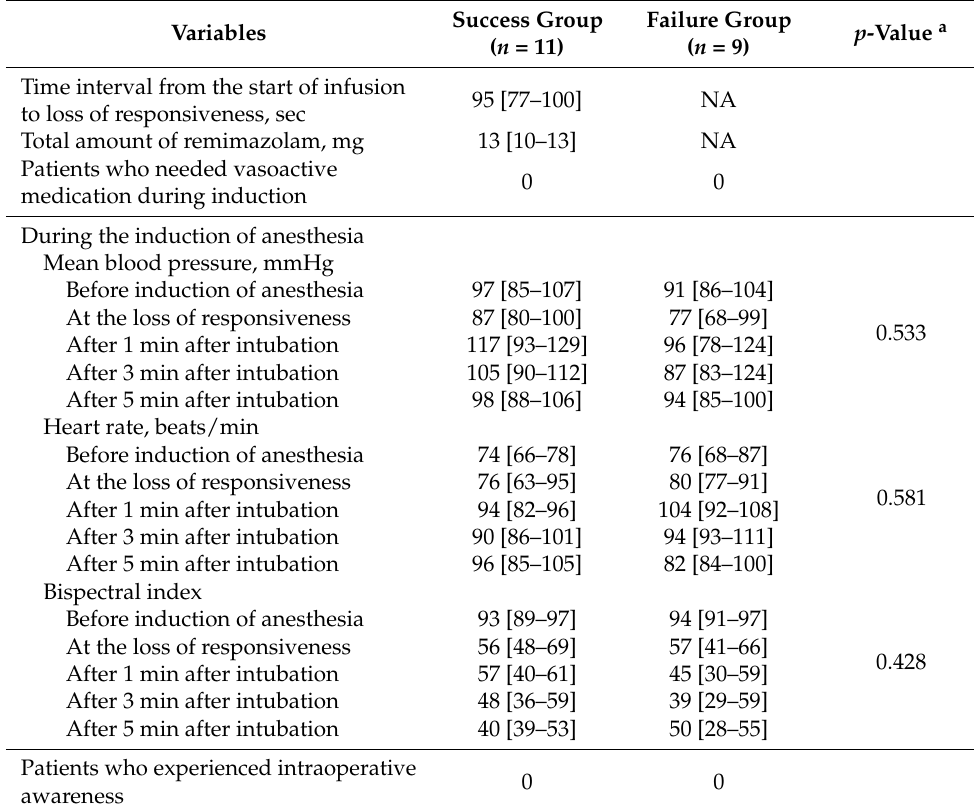
Table 3. Hemodynamic changes and secondary outcomes between the